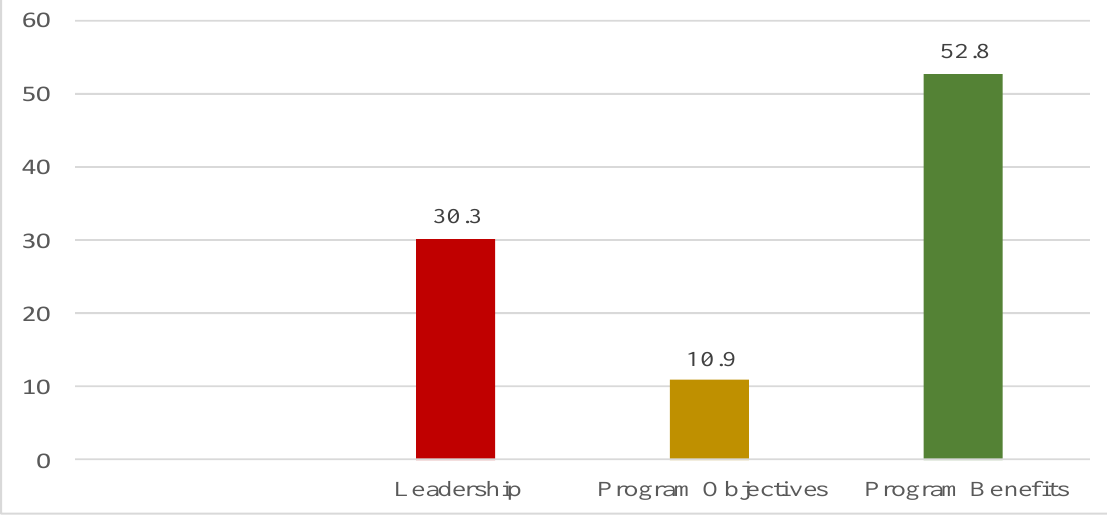
Figure 5: Institutional Determinants in Joint Funded Development